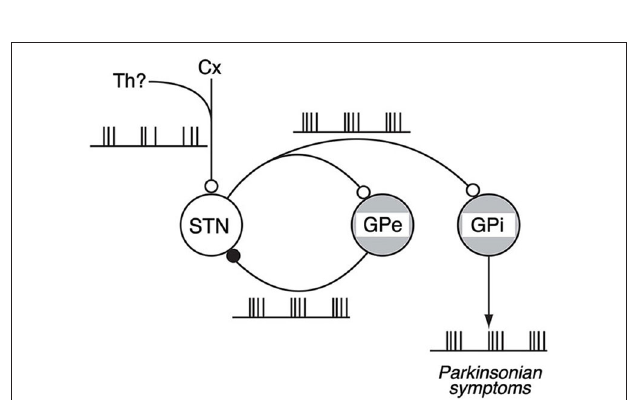
FIGURE 3 | Effects of GPe inactivation on STN neurons under the parkinsonian state . (A) Recording from STN neurons was performed with muscimol injection into the GPe to block GABAergic inputs from the GPe. (B) A representative STN neuron showing